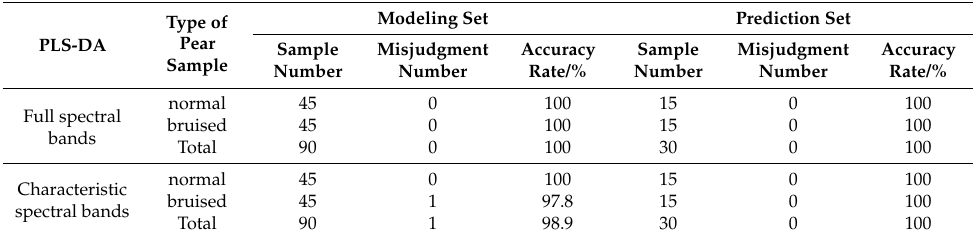
Table 2. Discriminant results of the partial least squares discriminant analysis (PLS-DA) model of modeling samples (45 normal pears and 45 bruised pears) and prediction samples (15 normal pears and 15 bruised